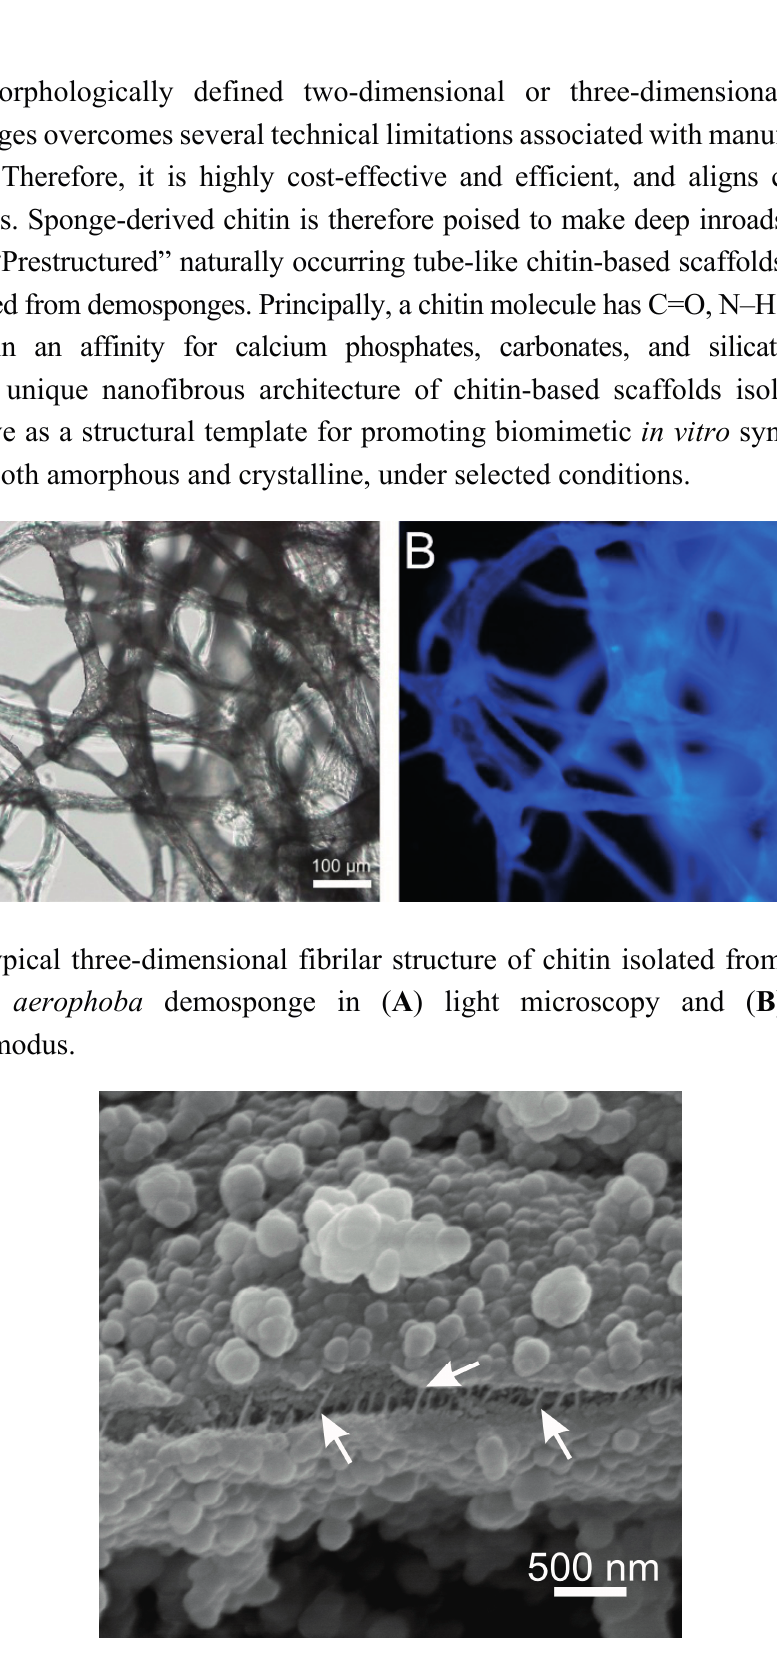
Figure 3. SEM (Scanning Electron Microscope) image of a microfracture on the surface of a chitin-silica composite obtained using hydrothermal conditions (for details see [114]). Due to this microfracture, the nanofibrillar organization of the chitinous matrix can be seen clearly